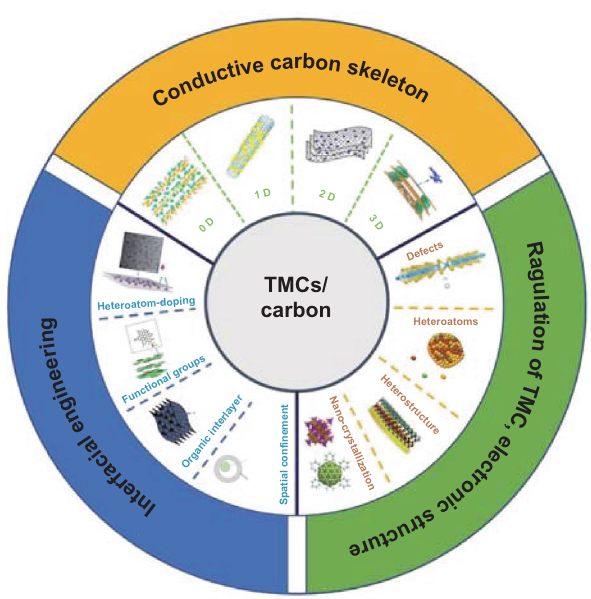
Fig. 1 Schematic illustration of strategies of TMCs/carbon hybrid